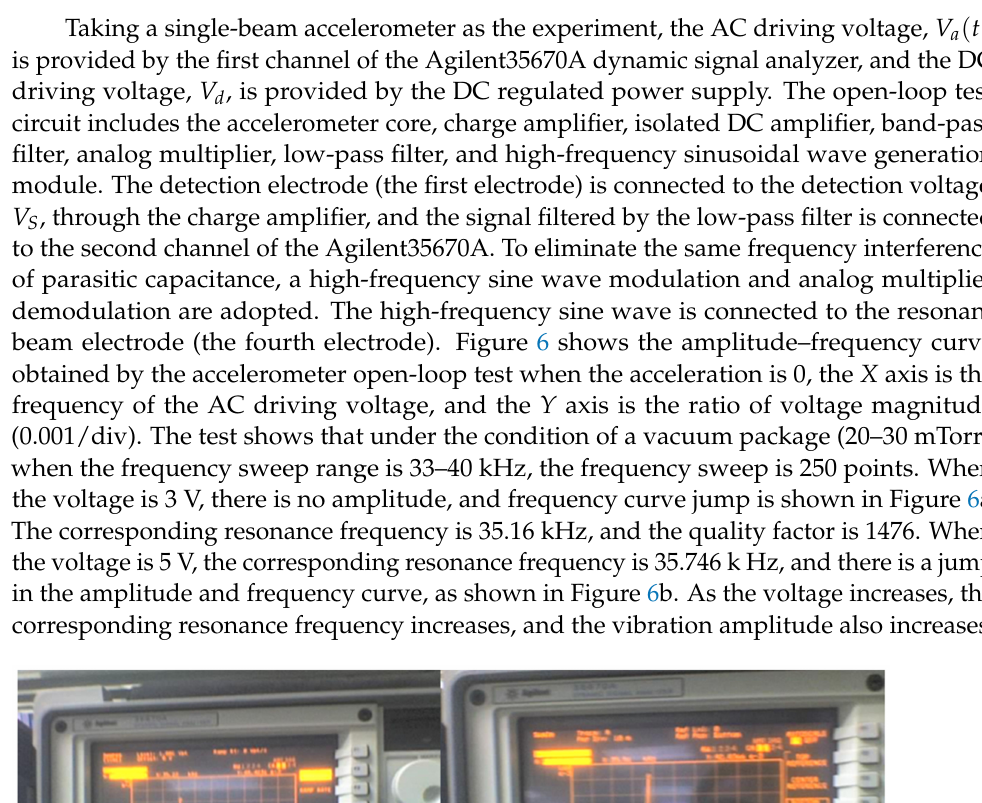
Figure 5. Open-loop parameter measurement circuit. The lower electrode connected to sensing voltage; The lower electrode connected to driving voltage; The electrode connected to the tuning fork beam; The upper electrode connected to driving voltage; The upper electrode connected to sensing voltage.